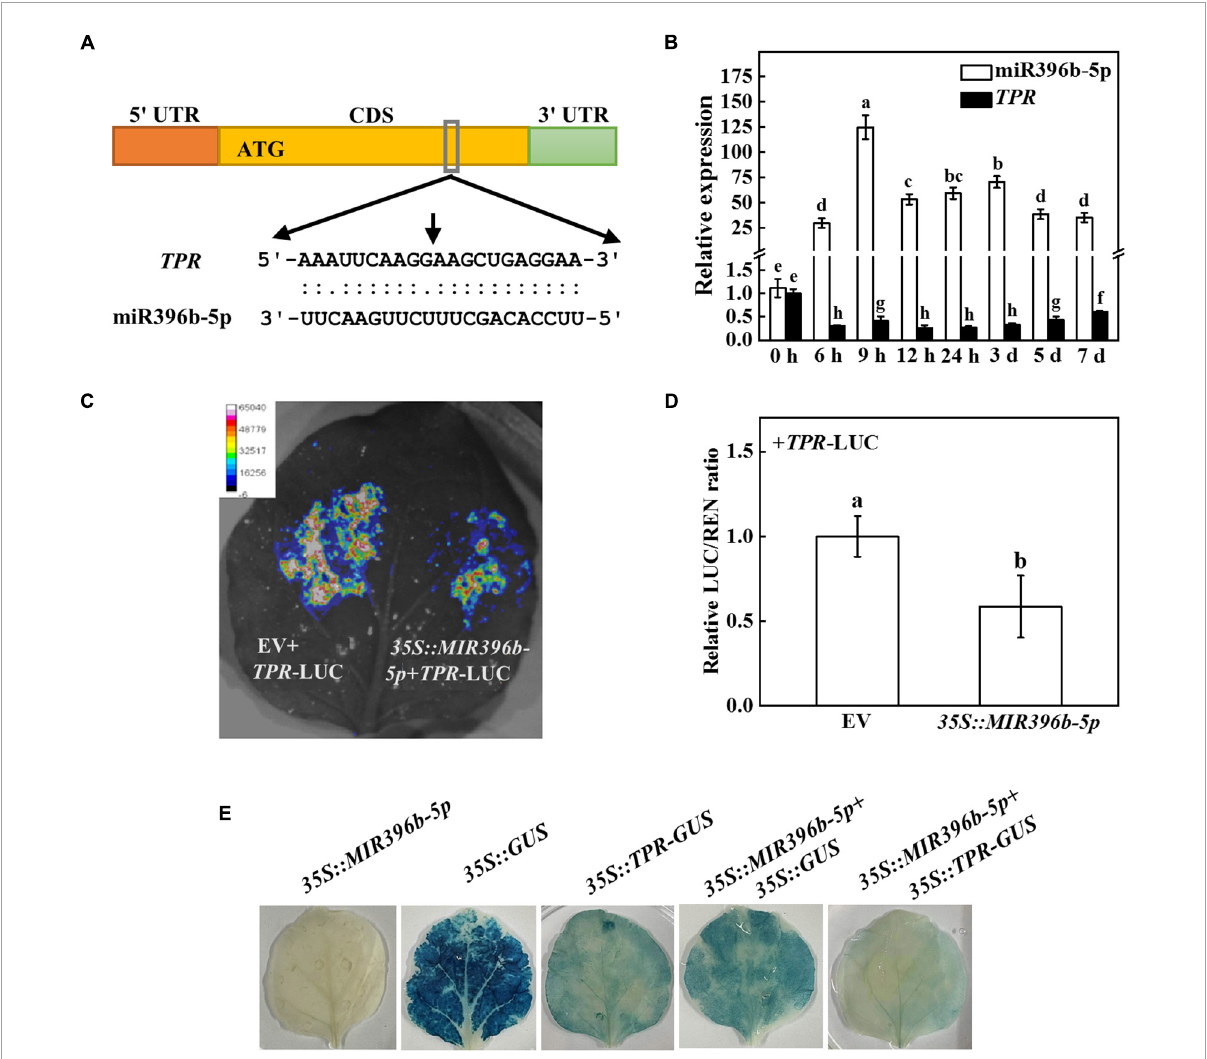
FIGURE3 Cucumber TPR is the target gene of miR396b-5p. (A) 5’ RLM-RACE verified that there was a cleavage site in TPR , and the cleavage site is indicated by a black arrow. (B) Effects of cold stress on the expression of miR396b-5p and TPR in cucumber. Cucumber plants were exposed to cold stress and the leaves were harvested at the indicated time point for analysis the expression of miR396b-5p and TPR by qPCR. (C,D) Dual-luciferase assay verification of miR396b-5p cleavage of TPR . Agrobacterium tumefaciens harboring the indicated plasmids were infiltrated into tobacco leaves, and the leaves were analyzed after infiltration for 2 d. The empty vector was used as a control. The results represent the mean ± SD ( n = 3). Means with the same letter did not significantly differ at P < 0.05 according to Tukey’s test. (E) GUS staining